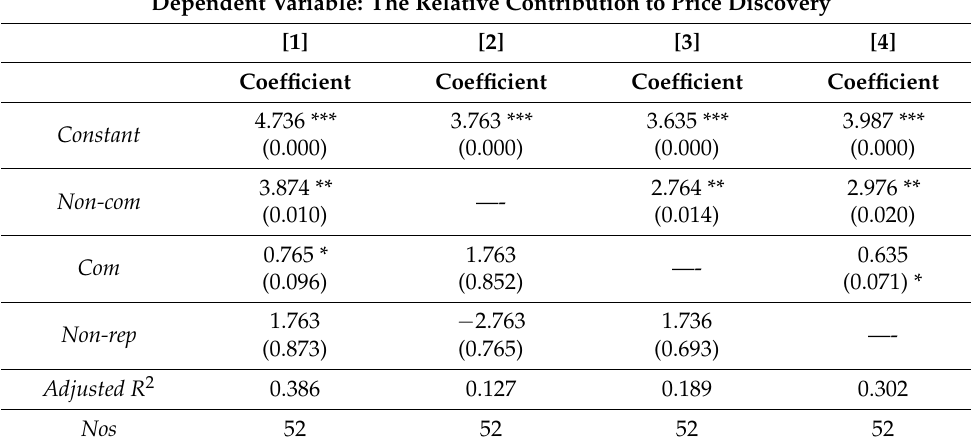
Table 4. Effects of trader’s positions on information share. Dependent Variable: The Relative Contribution to Price